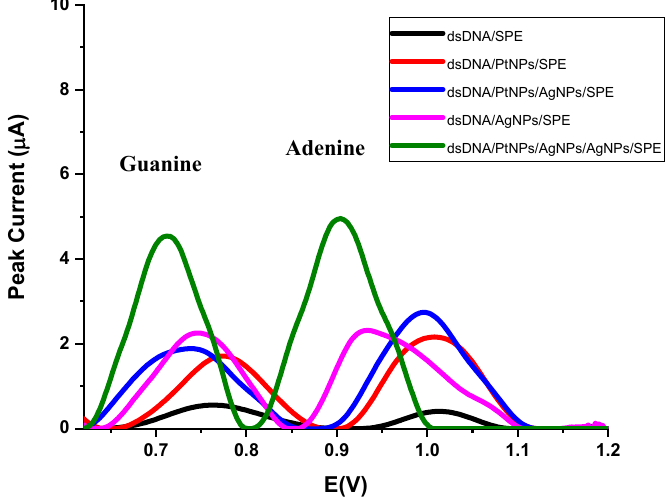
Figure 2. DPVs recorded at bare double-strand deoxyribonucleic acid (dsDNA)/SPE (black), dsDNA/PtNPs/SPE (red), dsDNA/AgNPs/SPE (pink), dsDNA/PtNPs/AgNPs/SPE (blue), and dsDNA/PtNPs/AgNPs/SPE (green) electrodes in pH 4.70 AB.